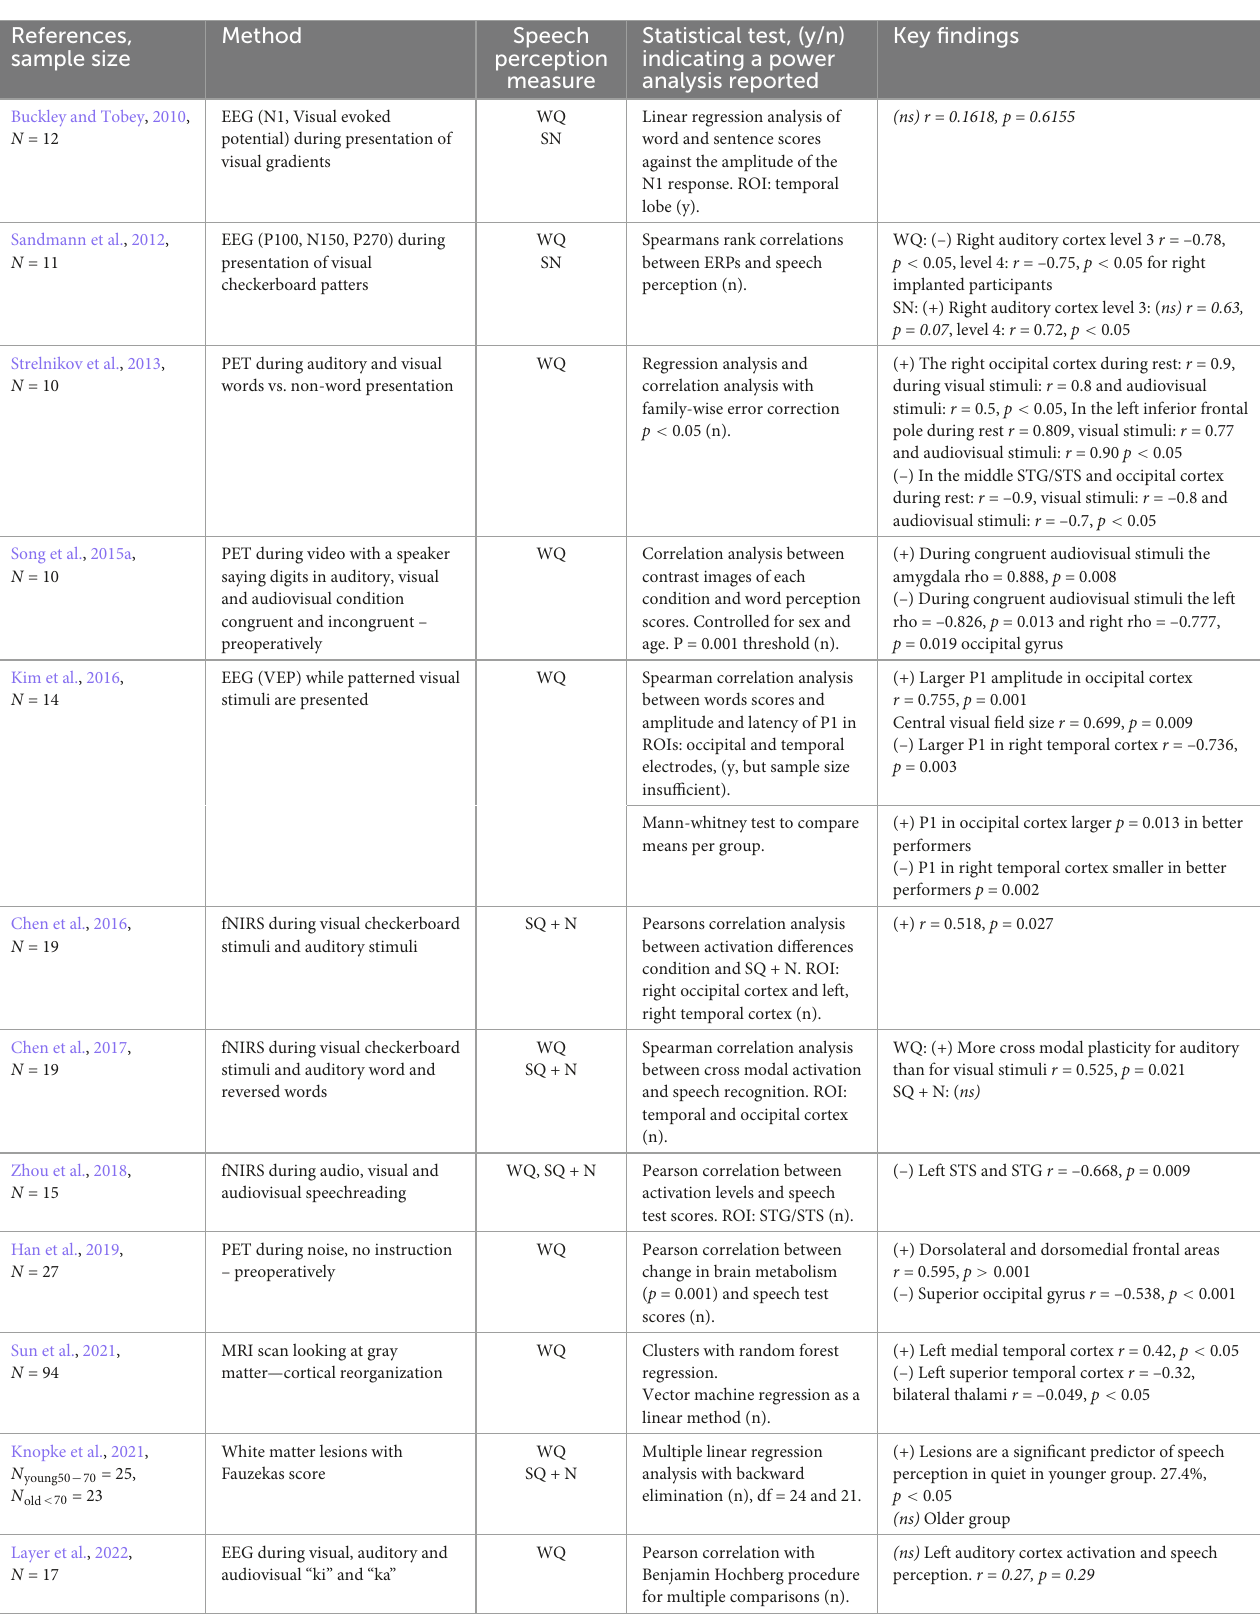
TABLE 2 Overview of included papers studying cross-modal